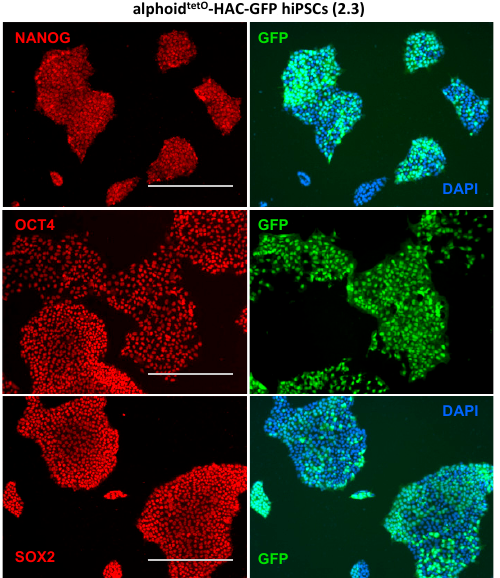
Figure 4. Alphoid tetO -HAC-GFP is maintained as an independently replicating chromosome in human pluripotent stem cells (hiPSCs), as revealed by fluorescence in situ hybridization (FISH) analysis using the tetO-PNA-FITC as a probe. The human artificial chromosome (HAC) (arrow) within the alphoid tetO -HAC-GFP carrying iPSC clone R1 ( a ) and sub-clone R2.2 ( b ) colocalizes with diamidino-2-phenylindole (DAPI) (blue) but not with the telomere labeling PNA-TRITS probe (red) specific exclusively for host chromosomes. ( c ) Representative results of karyotype analysis of the initial hiPSCs and the alphoid tetO -HAC-GFP hiPSCs (clone R1), showing normal 46XX karyotype.